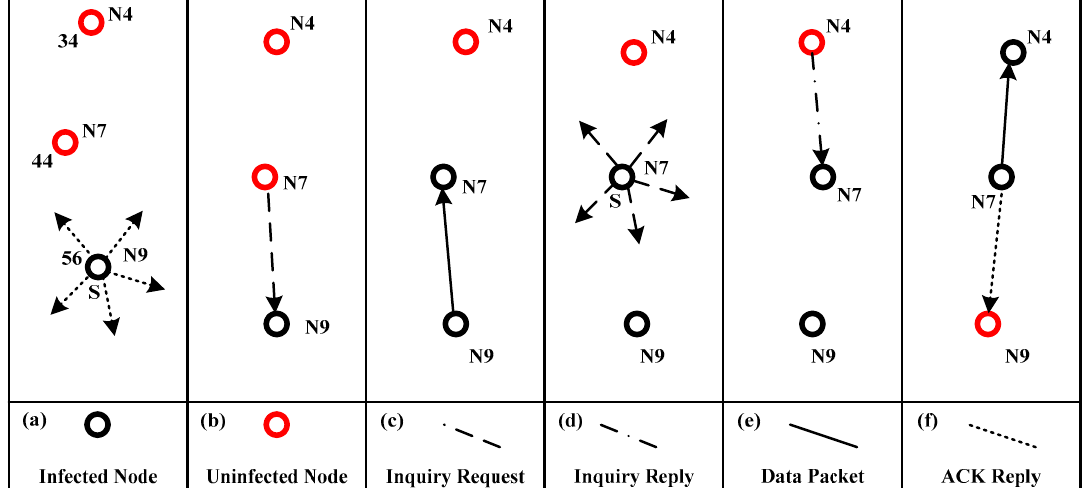
Figure 8. Data packet forwarding in 2H ‐ ACK.